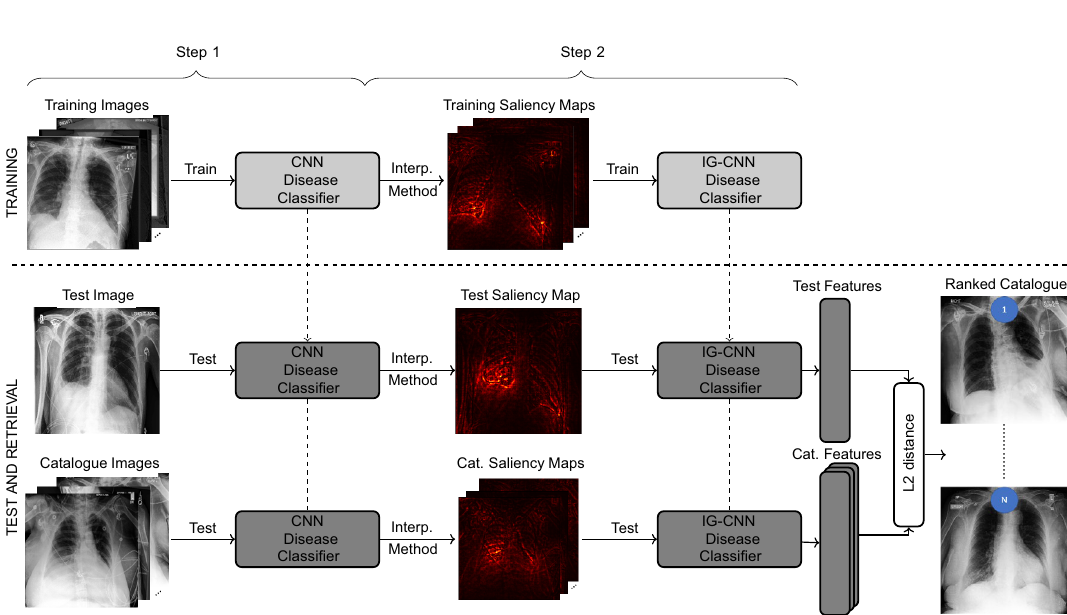
Figure 4. Overview of the proposed Interpretability-guided approach. Blocks in light gray ( ) mean neural networks are being trained (i.e., weights are being updated), whereas blocks in dark gray ( ) represent trained neural networks (i.e., weights are fixed). In the saliency maps, brighter colors mean higher relevance. Blue circles indicate ranking positions. CNN represents the deep model used as baseline. IG-CNN represents the CNN model architecture being trained with saliency maps. The L2 distance is computed between the test image’s latent features and each catalogue image’s latent